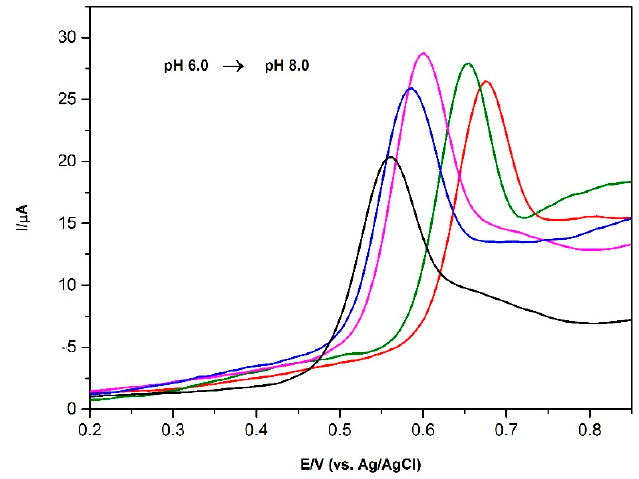
Figure 7. Square wave adsorptive stripping (SWAdS) voltammograms of 2 μ M BPA at AuNP/PVP/PGE in different pH (6.0, 6.5, 7.0, 7.5, 8.0) in 0.1 M PBS. Conditions: pH 7.0; frequency: 50 Hz; step amplitude: 40 mV; pulse amplitude: 5 mV; E dep : − 0.2 V; t dep : 60 s.